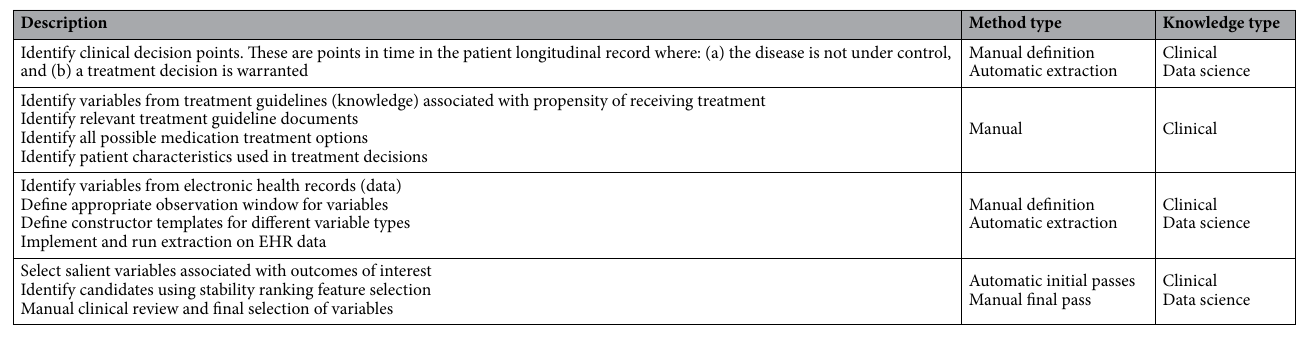
Table 1. Data extraction